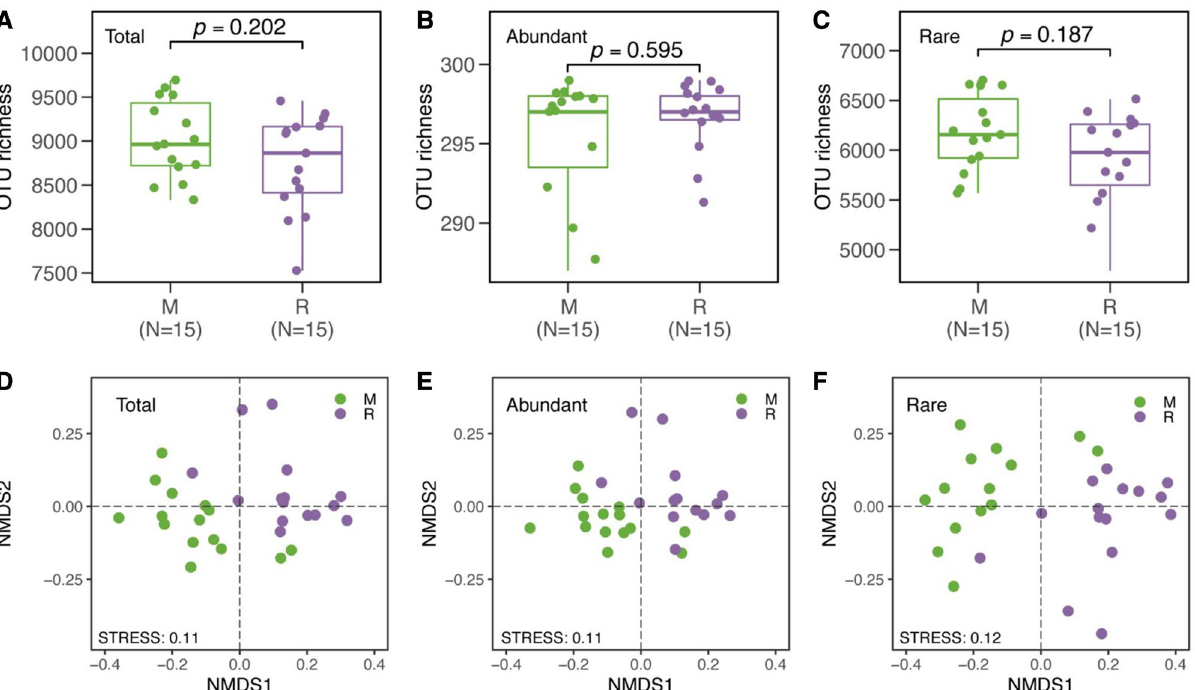
Figure 3. OTU richness of the total, abundant, and rare taxa in tobacco monoculture and tobacco-rice rotation ( A – C ); and bacterial community composition of the total, abundant, and rare taxa in tobacco monoculture and tobacco-rice rotation as indicated by non-metric multidimensional scaling (NMDS) ( D – F ). Total whole bacterial communities, Abundant abundant taxa, Rare rare taxa, M tobacco monoculture, R tobacco-rice rotation.